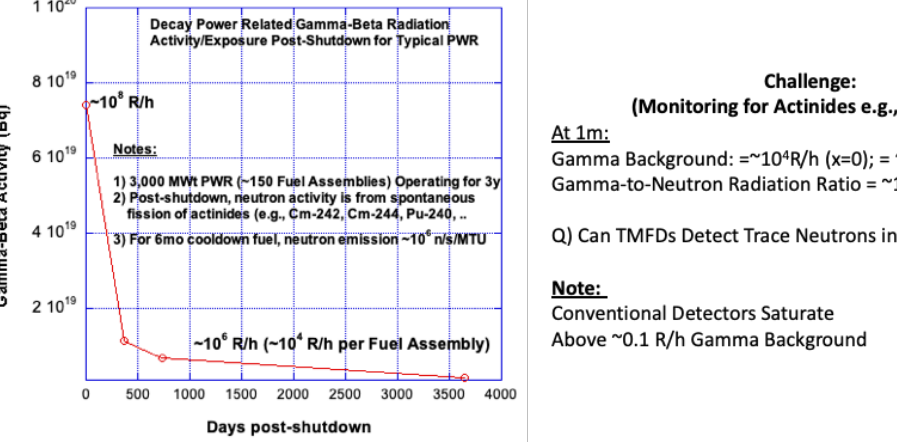
Figure 2. Variation of radiation activity with time for spent nuclear fuel and monitoring challenges in an extreme gamma background.